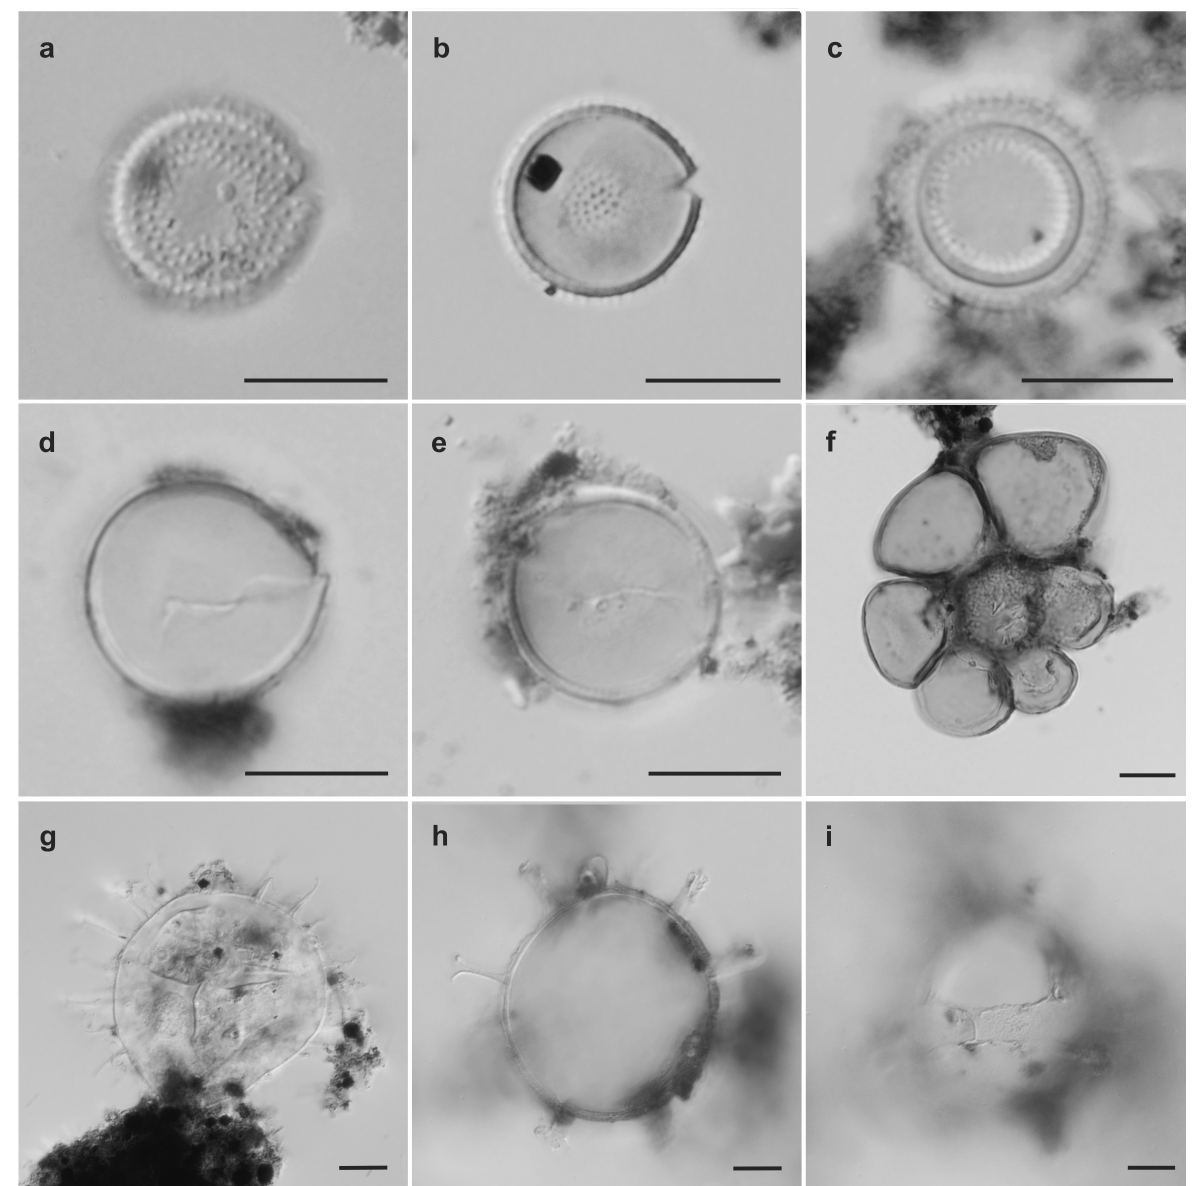
Figure 4 - Photomicrographs of marine palynomorphs retrieved from the PCSC-3 core. a-b : Micrhystridium sp. (Slide MPP-9981, England Finder coordinate N41-1); ( a : high focus, b : intermediate focus); c : Acritarch sp. 1 (MPP-9937, T51-2); d-e : Acritarch sp. 2 (MPP-9981, U39-3 and D44-1); f : Microforaminiferal linings (MPP-9976, U43); g : Operculodinium sp. (MPP-9972, F65); h-i : Spiniferites sp. (MPP-9982, P38-4); ( h : intermediate focus and i : high focus). Scale = 10